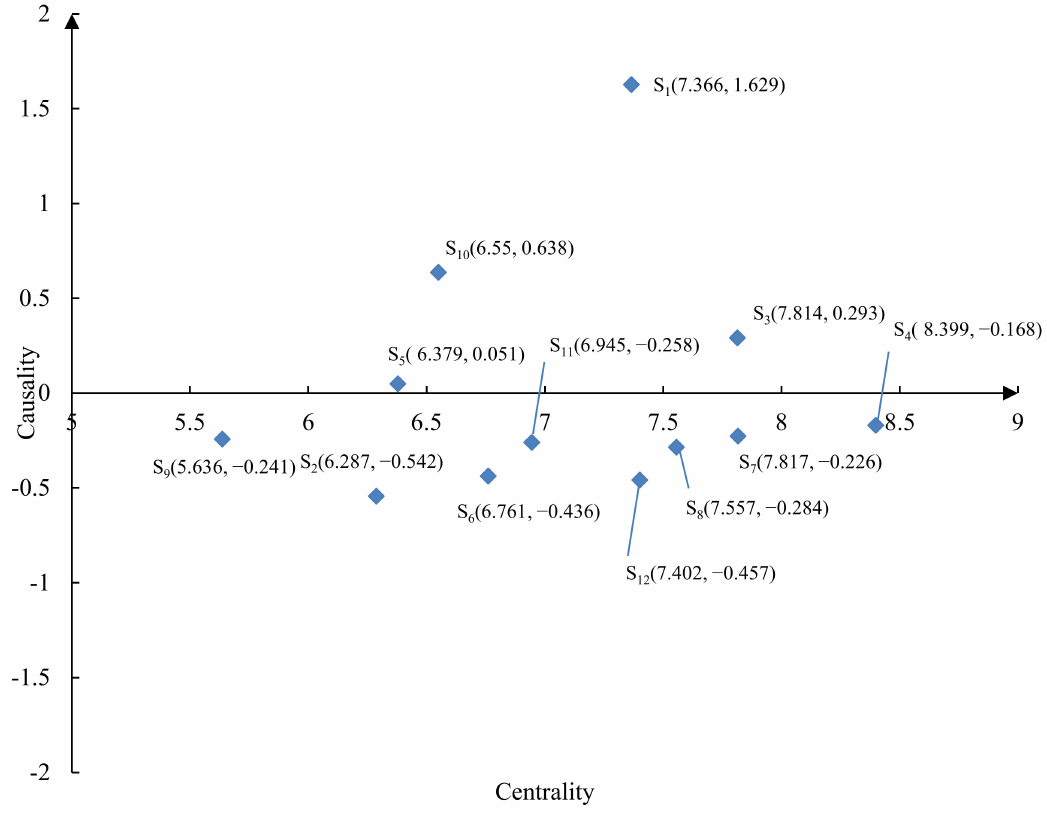
Figure 3. Cause–effect